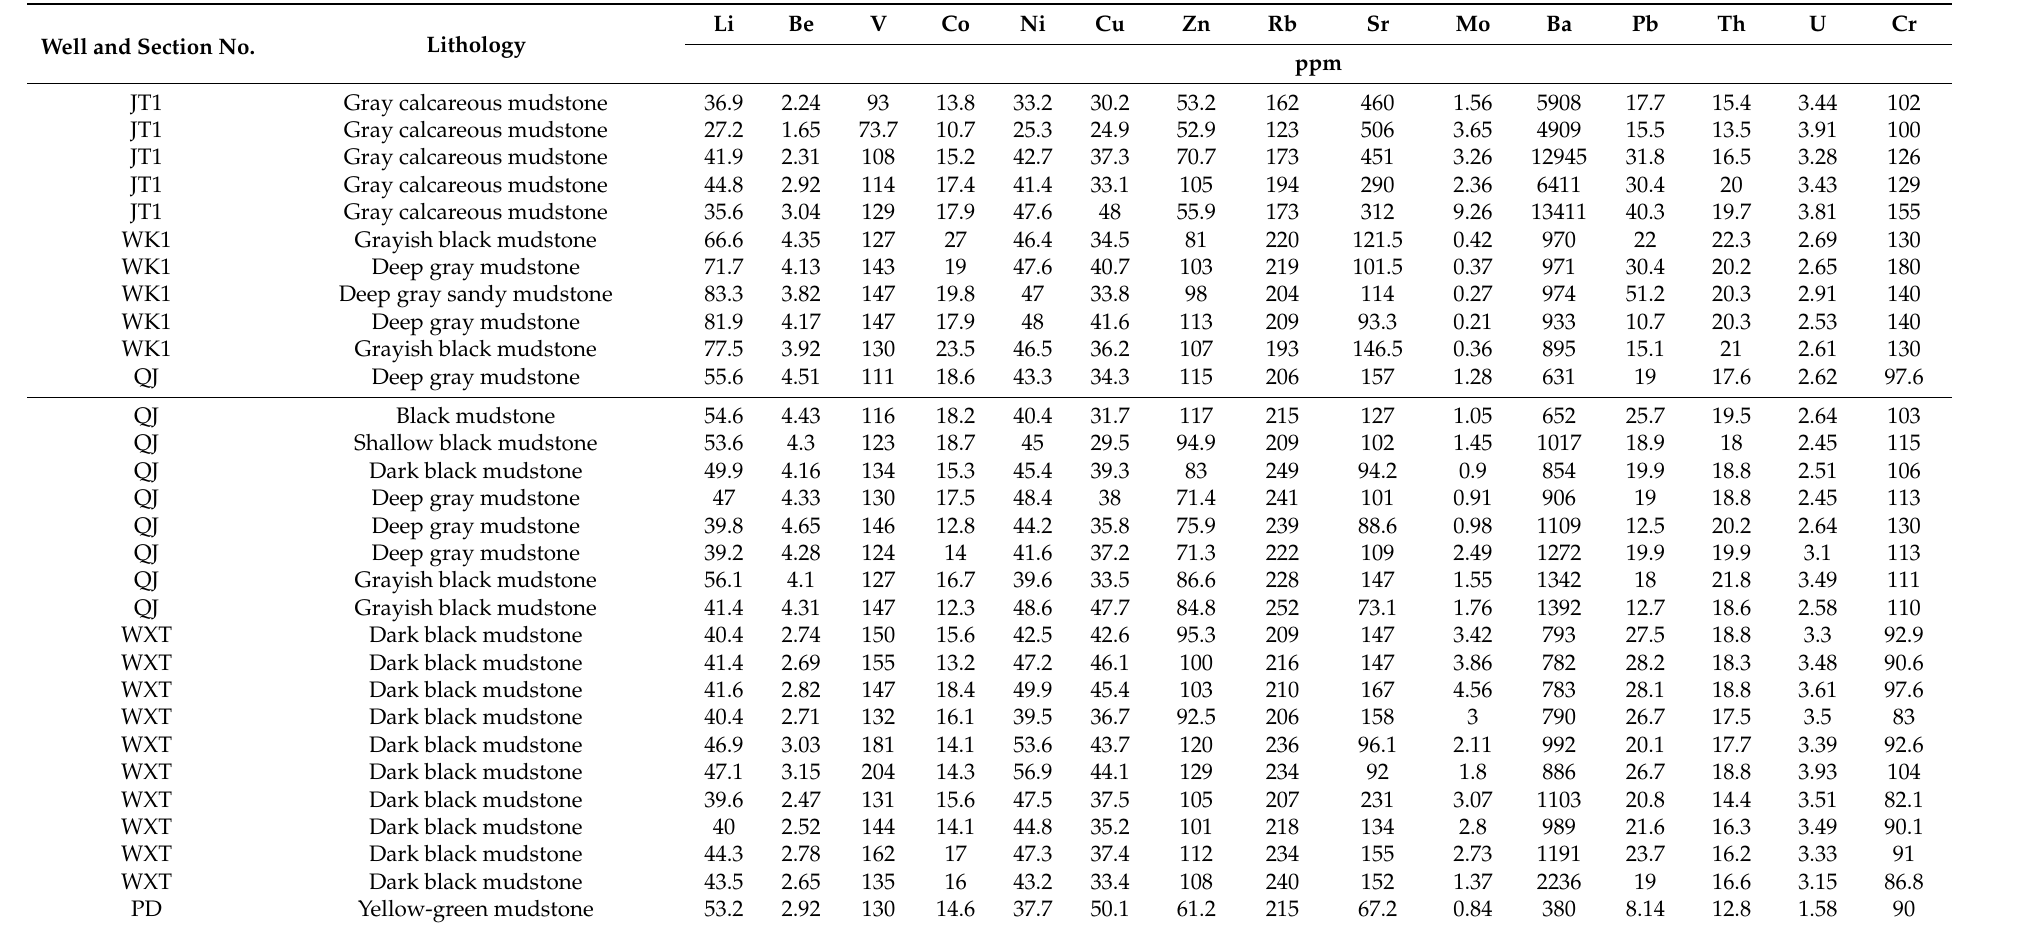
Table 2. Trace elements of mudstones in the Meitan